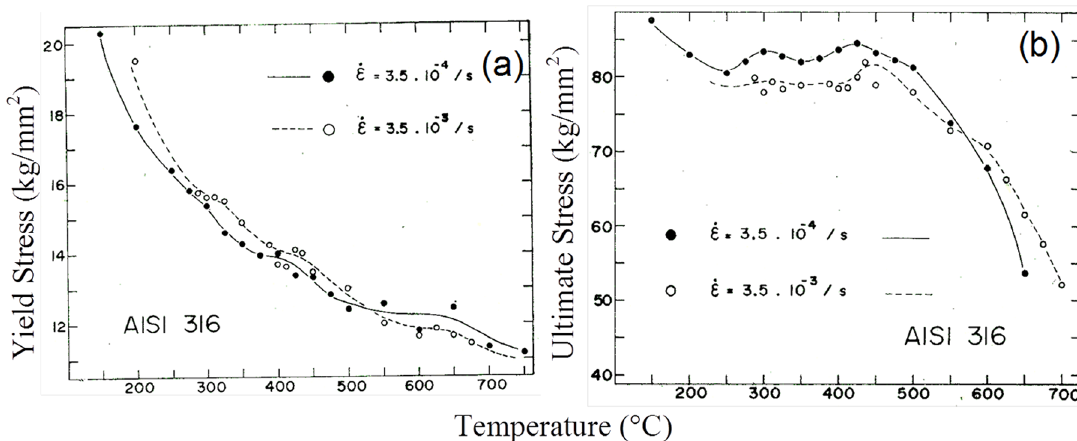
Figure 2. Variation of (a) yield stress and (b) ultimate stress of type AISI 316 stainless steel with temperature for two strain rates.